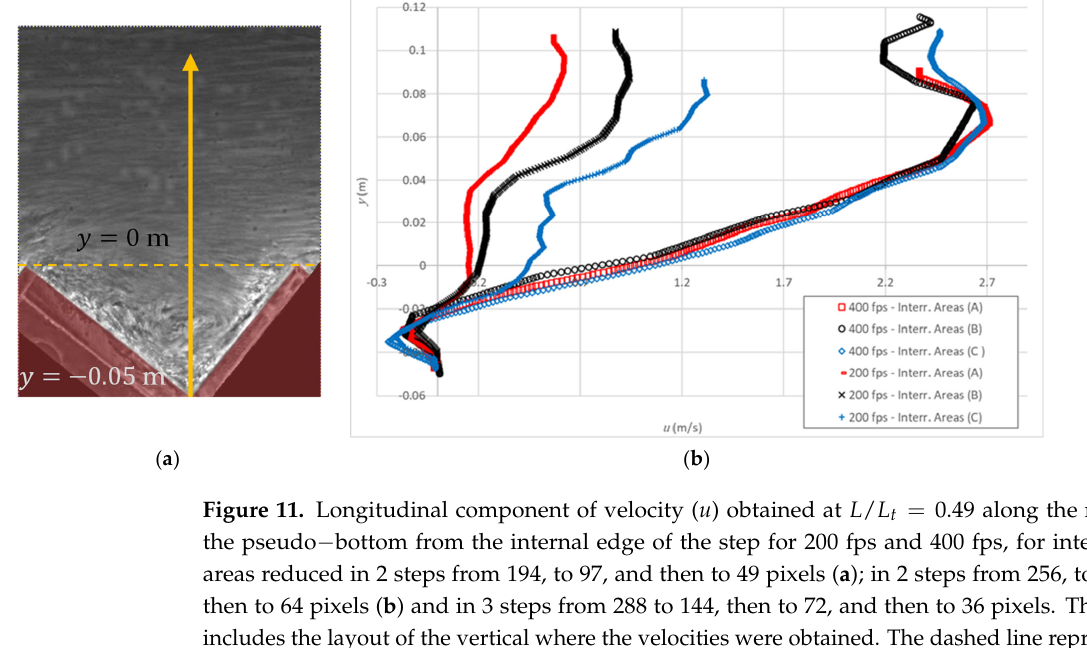
Figure 10. Average velocity field obtained at /  = 0.49 for   /ℎ = 2.38 and ( a ) 200 fps ( b ) 400 fps, when reducing the interrogation area in 3 steps from 288 to 144, then to 72, and then to 36 pixels.